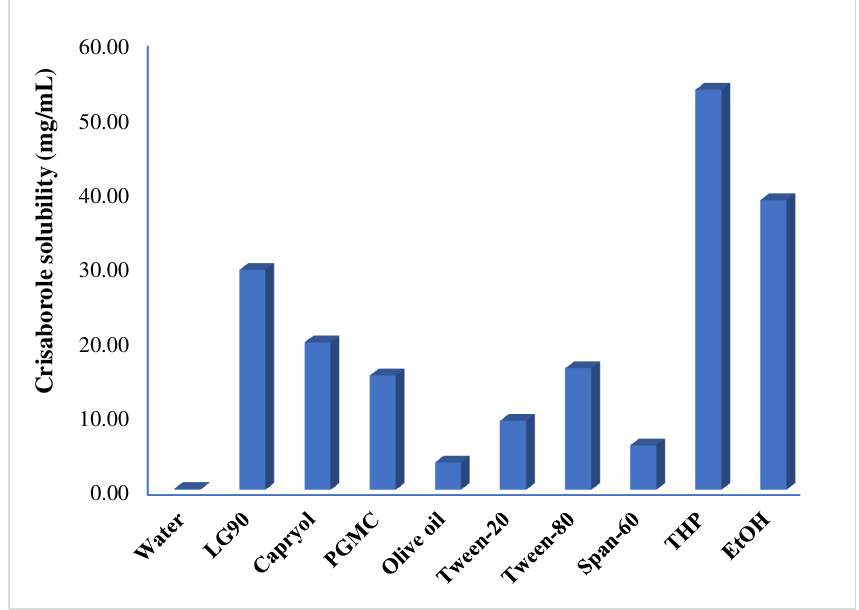
Figure 2. Solubility profile of crisaborole (CRB) in different components.